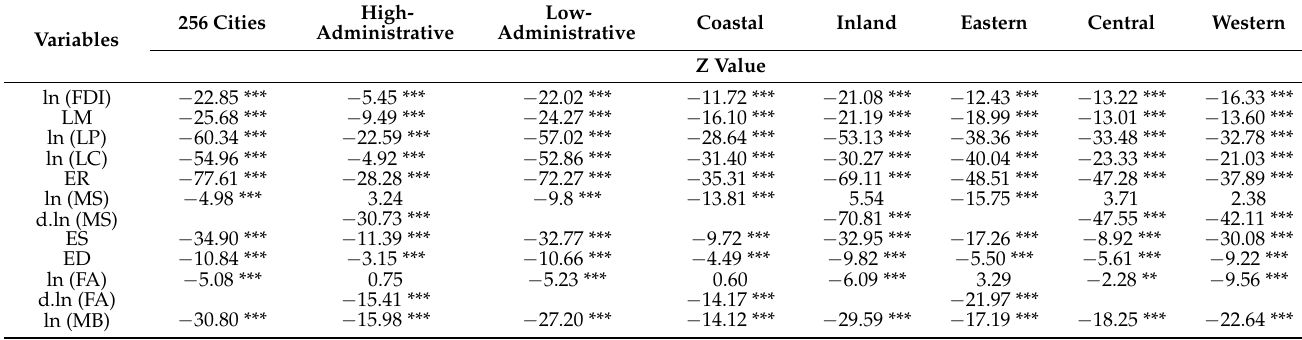
Table 2. Unit root